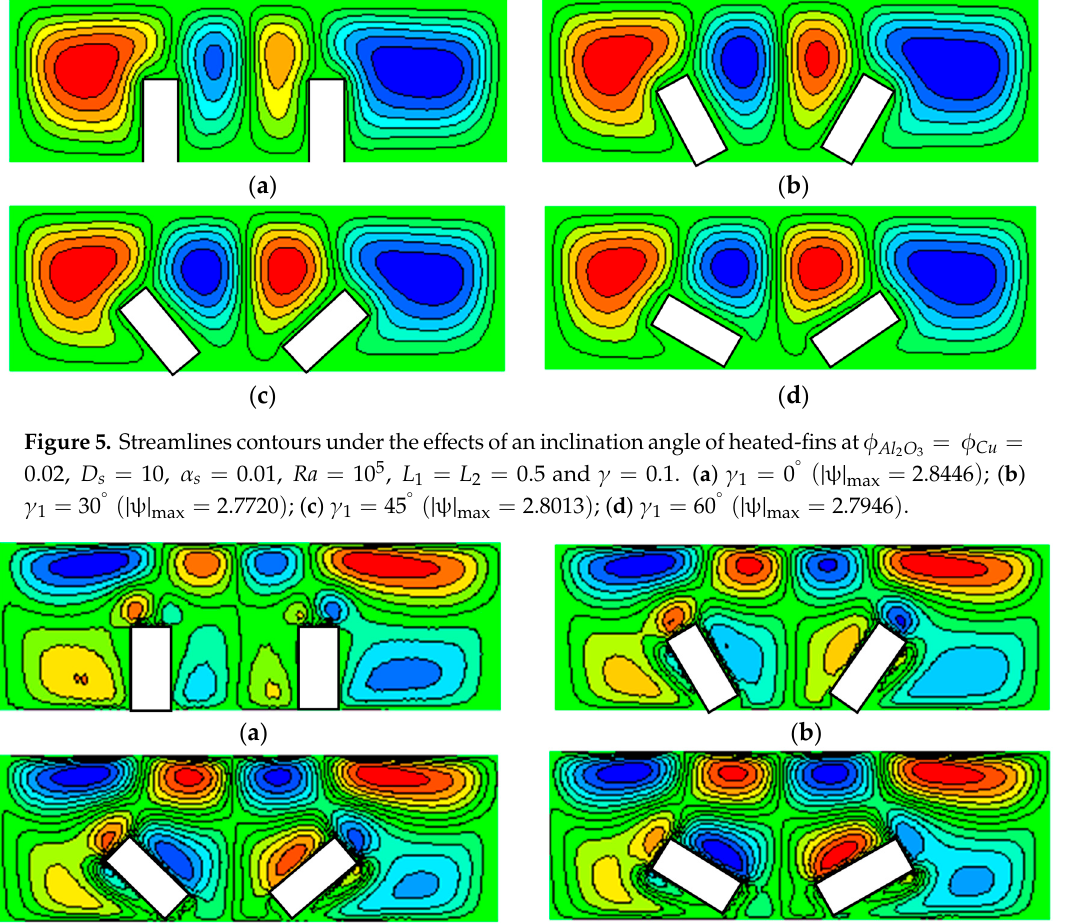
Figure 4. Isothermal contours under the effects of an inclination angle of heated-fins at 𝜙 (cid:3002)(cid:3039) 𝜙 (cid:3004)(cid:3048) = 0.02, 𝐷 (cid:3046) = 10, 𝛼 (cid:3046) = 0.01, 𝑅𝑎 = 10 (cid:2873) , 𝐿 (cid:2869) = 𝐿 (cid:2870) = 0.5 and 𝛾 = 0.1 . ( a ) 𝛾 (cid:2869) = 0 ° ; ( b ) 𝛾 (cid:2869) = 30 ° ; ( c ) 𝛾 (cid:2869) = 45 ° ; ( d ) 𝛾 (cid:2869) = 60 ° .